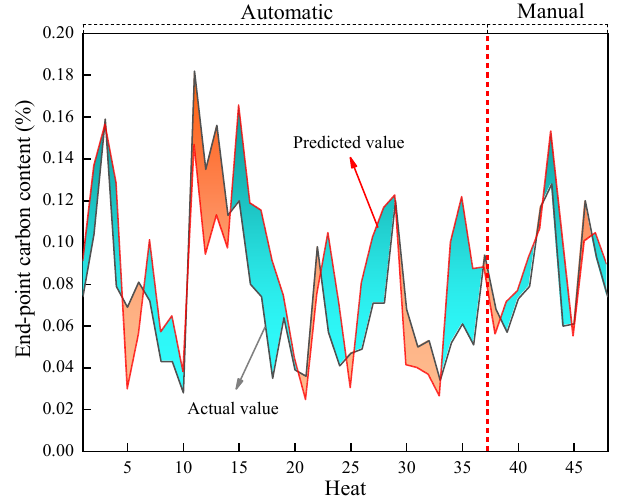
Figure 11. Comparison of predicted and actual values of end-point carbon content in field applica-